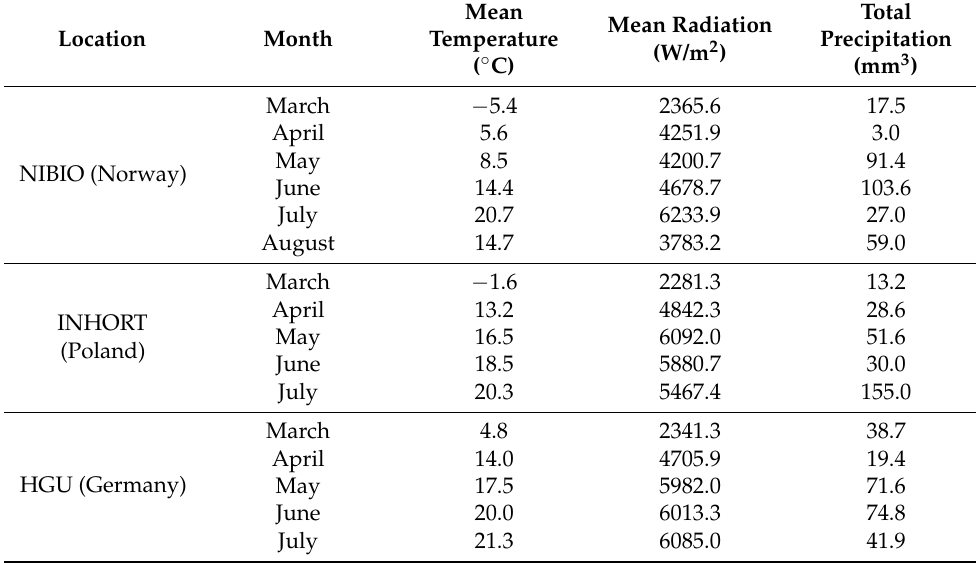
Table 1. Climatic factors at the locations where fruits were harvested. Values are placed